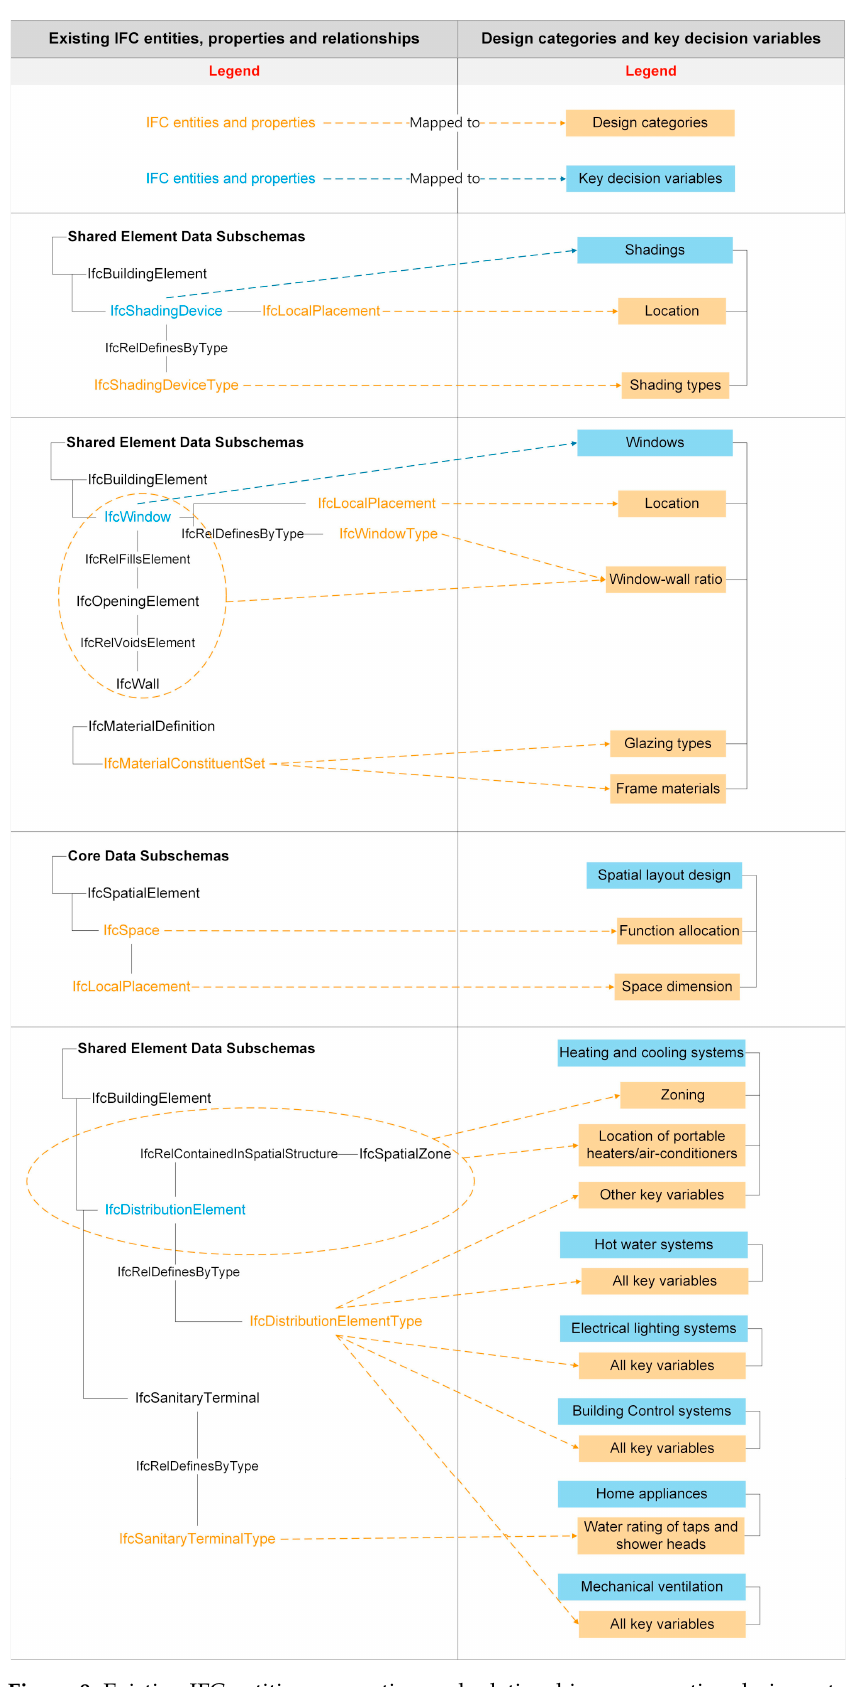
Figure 9. Existing IFC entities, properties, and relationships representing design categories and key decision variables affecting net-zero-carbon building outcomes at design stage (continued).